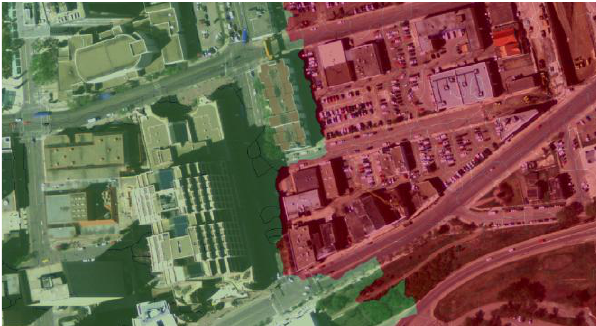
Figure 10. An example of the graph-cut results superimposed on the left image Figure 11(a-c) depict few examples of seamline results around human-made objects as well as natural barriers (i.e., canopy lines). It can be seen from these examples that the constraint mask works well in influencing the seamline behaviour. In these images, the pixels on the left of the seamline belong to the left image and the ones to the right of the seamline belong to the right image. Note also that the results are shown without feathering or pixel blending for the pixels closest to the seamlines. More seamline examples are also shown in Figure 14 and Figure 15